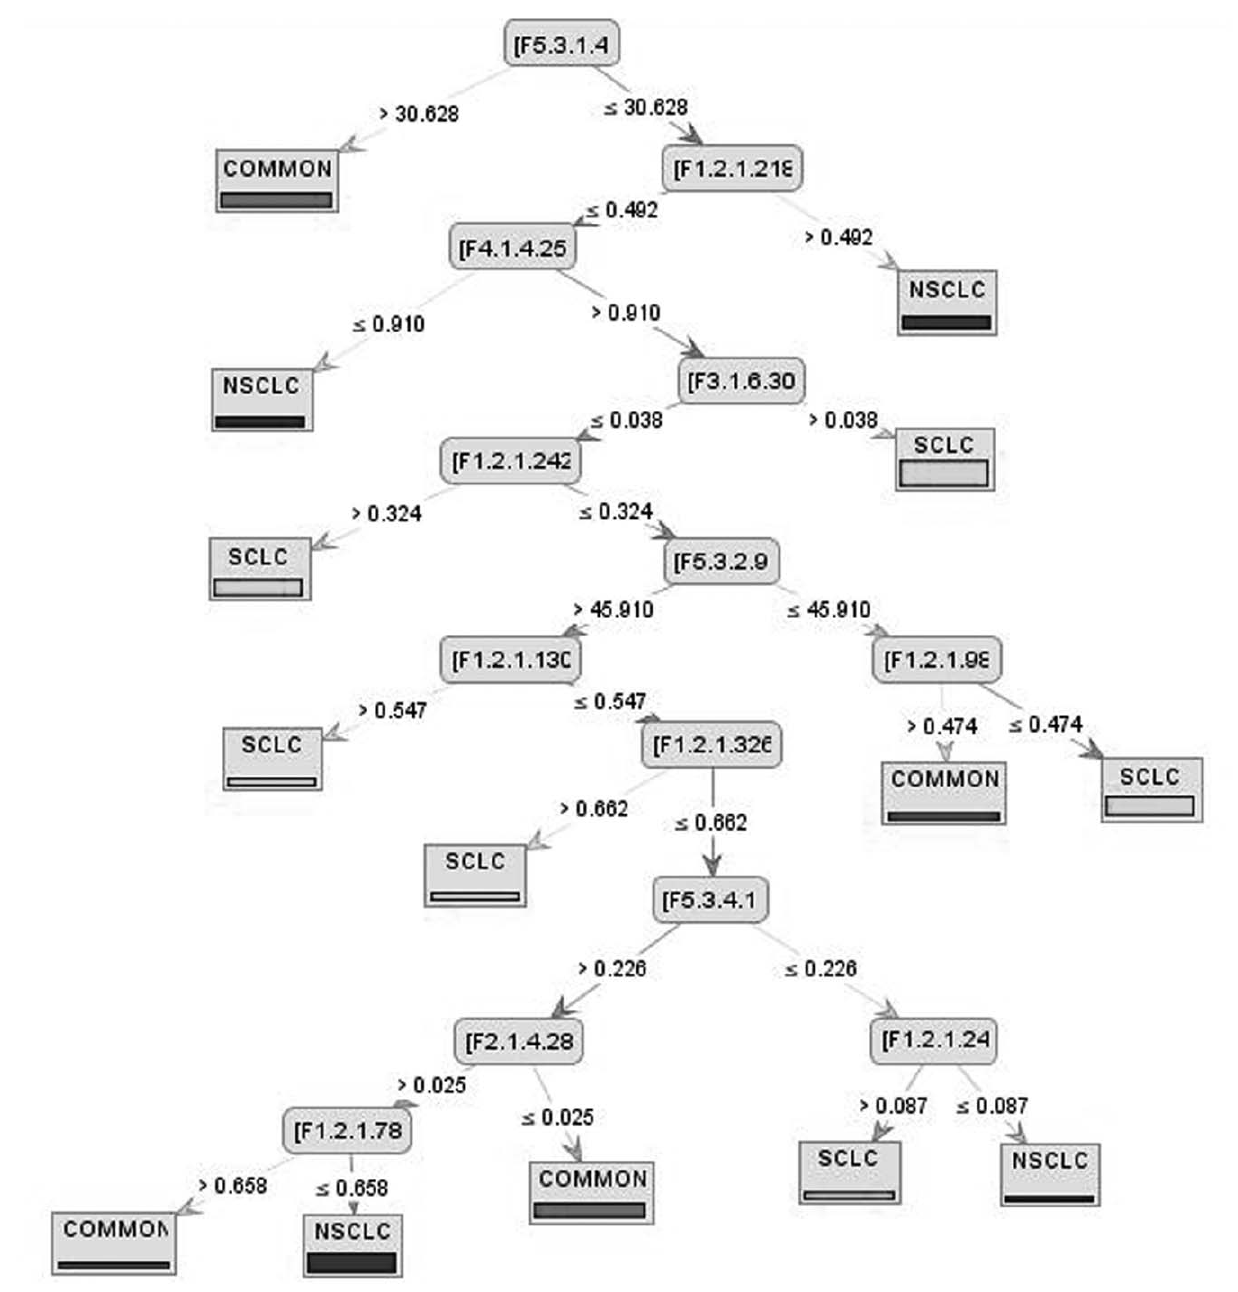
Figure 1. Decision Tree model on Information Gain dataset.